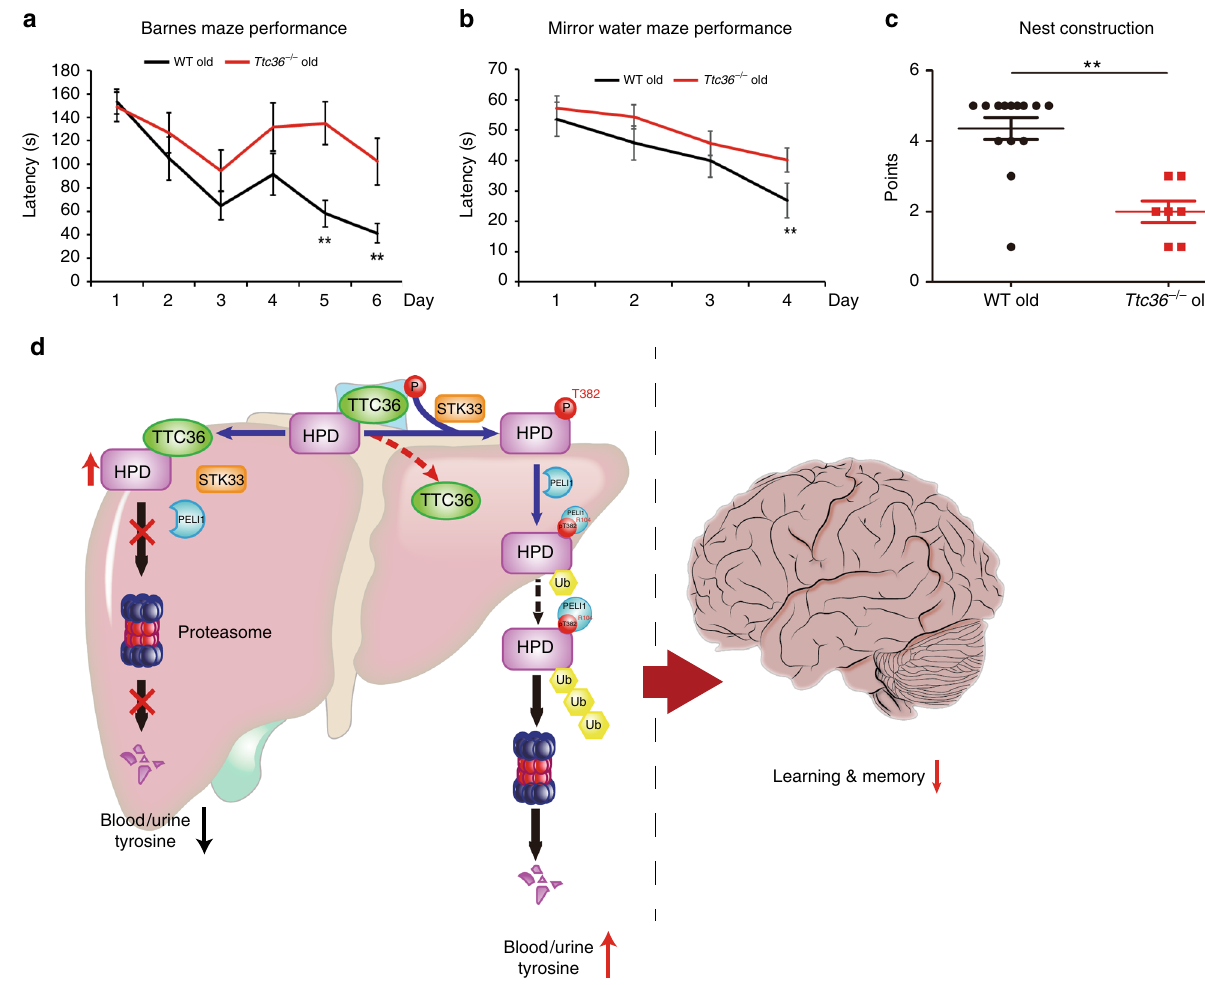
Fig. 6 TTC36 de fi ciency in mice results in impaired learning and memory. a Mean escape latency per training block for the aged wild-type and Ttc36 − / − mice (8 – 12 months, WT group: n = 13, Ttc36 − / − group: n = 11), Mean± s.e.m. b Mean escape latency for the aged wild-type and Ttc36 − / − mice (8 – 12 months, WT group: n = 13, Ttc36 − / − group: n = 10) during retention probe trial, Mean± s.e.m. c Nest construction was quanti fi ed in aged wild-type and Ttc36 − / − mice (8 – 12 months, WT group: n = 14, Ttc36 − / − group: n = 7) mice. Data from panels a and c are analyzed by two-way ANOVA with Sidak ’